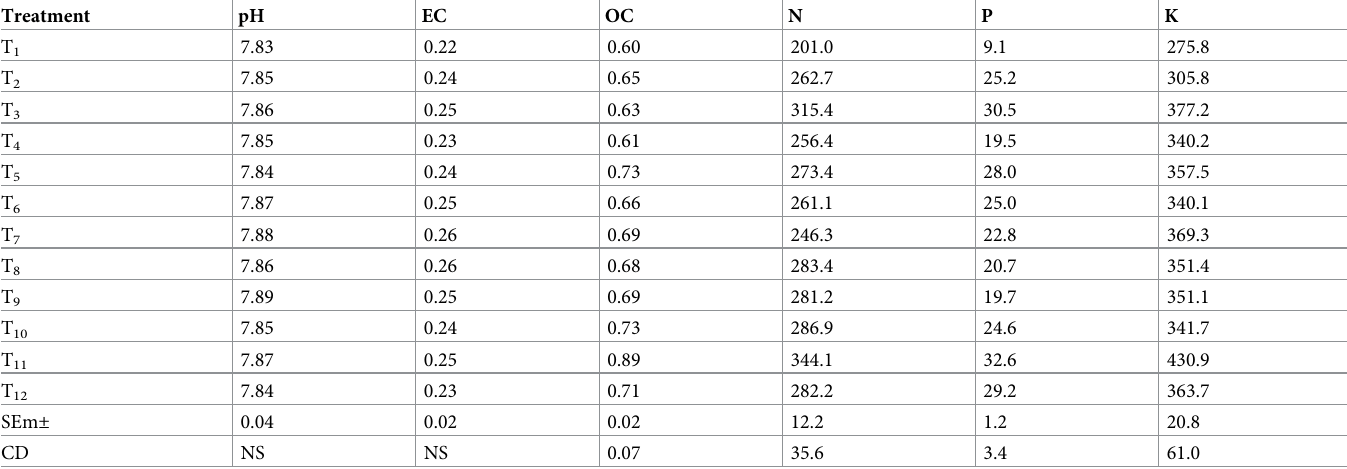
Table 5. The effect of various INM modules on soil properties (0–15 cm) at chickpea harvest.